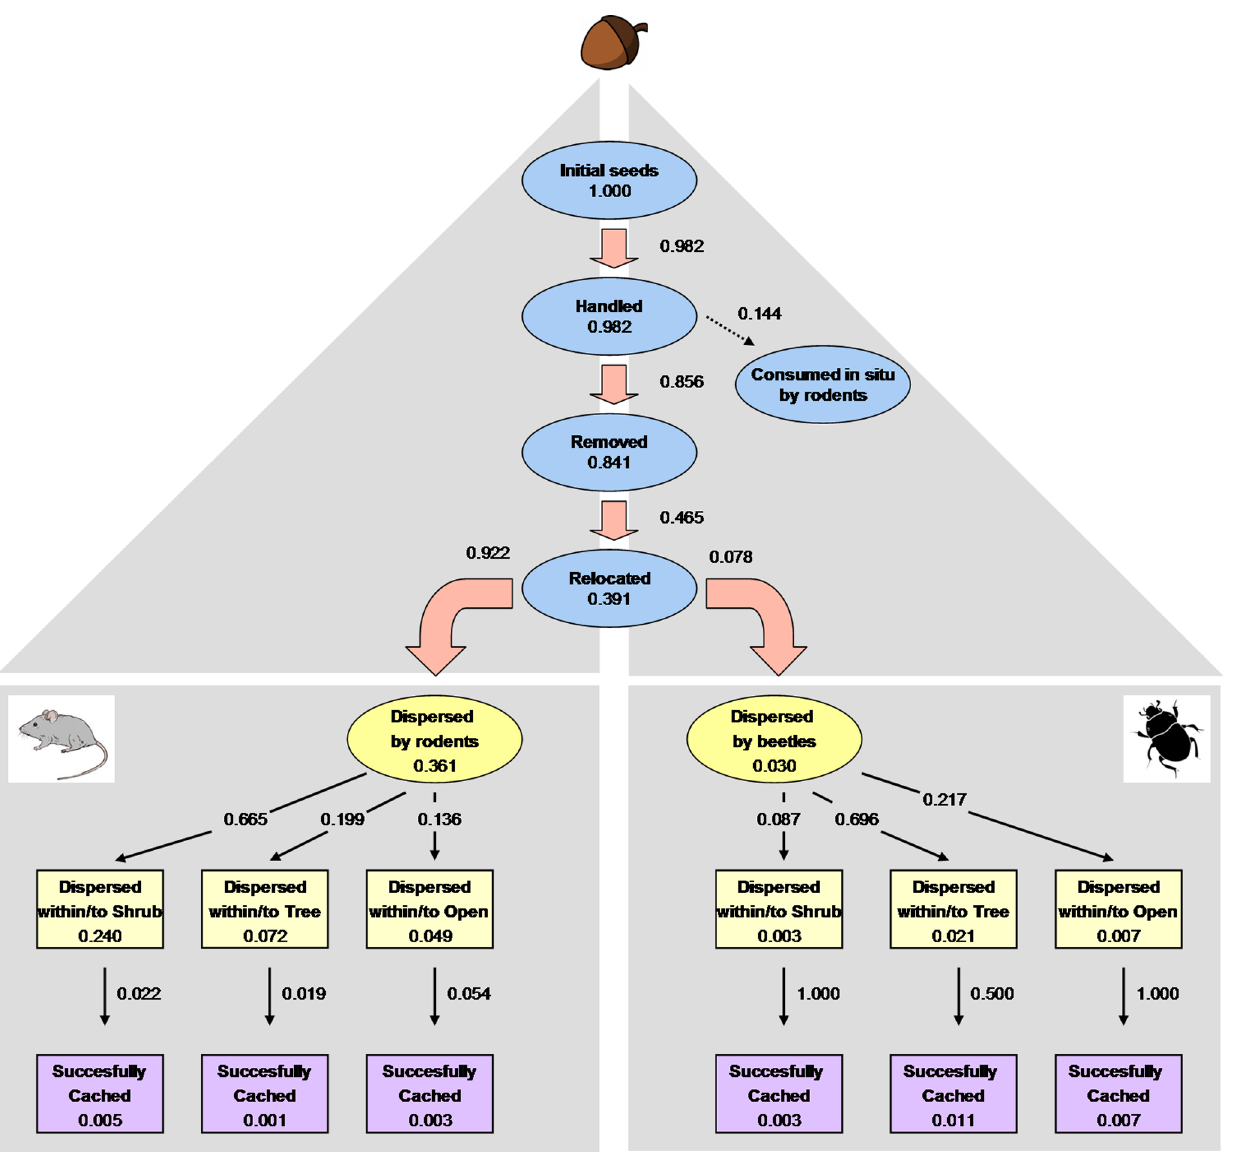
Figure 2. Summary diagram of acorn fate. The values next to the arrows indicate the transition probabilities among the different categories; the values inside boxes indicate the proportion of the initial experimental acorns (N=1080) still alive at each of these categories. Transition probabilities were calculated by mixing the two sampling periods (2009/2010 and 2010/2011) and the two oak species ( Q. suber and Q. canariensis ). ‘Cached’ and ‘undamaged’ have been grouped into the same category because we did not find any case of removed and non-cached acorns that remained viable over the whole sampling period.